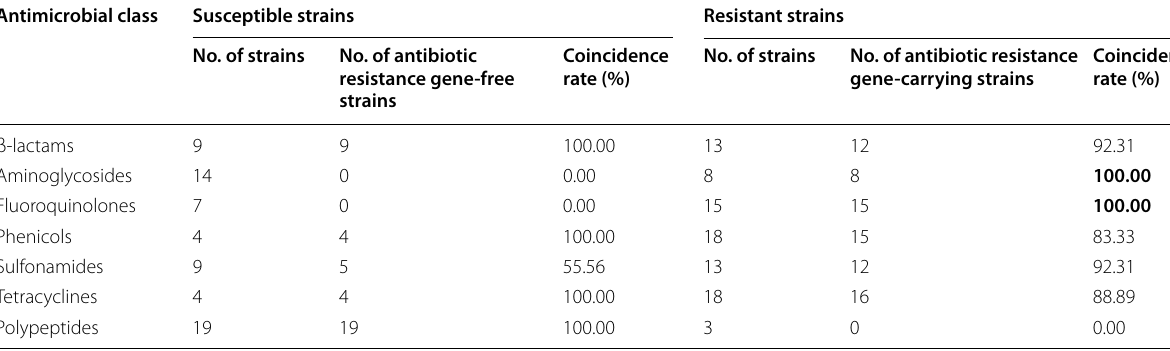
Table 2 The coincidence rates of resistance phenotypes and resistance genes Antimicrobial